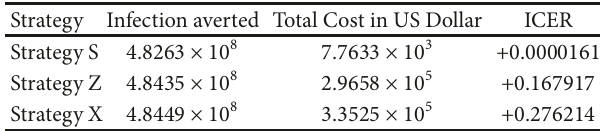
Table 5: The cost and infection averted for controls S, Z, and X. Strategy Infection averted Total Cost in US Dollar